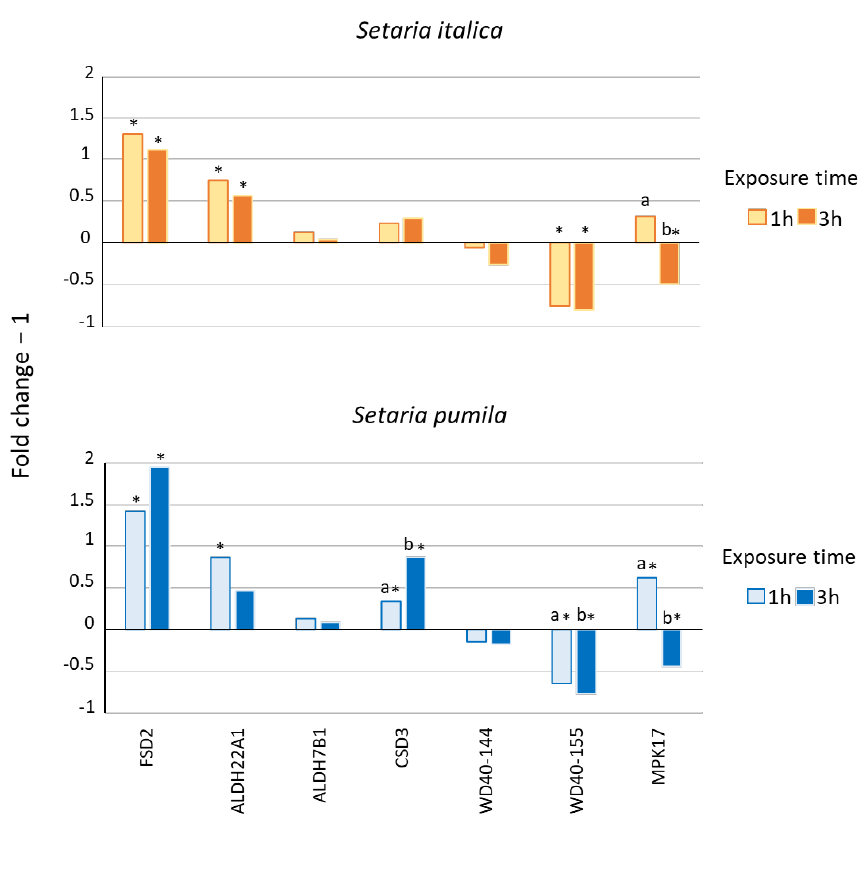
Figure 2. Target gene expression profiles in the two Setaria species after 1 and 3 h exposure to self-DNA. Data refer to fold change − 1 for each target gene after exposure to ultra-purified self-DNA solutions, for 1 and 3 h, at the concentration of 90 ng/µL. Different letters above bars indicate statistically significant differences in ∆ Cq means between exposure times within each gene ( t test for independent samples with Bonferroni’s correction for multiple comparisons). Asterisks indicate ∆ Cq means that are significantly different from the controls ( t test for independent samples with Bonferroni’s correction for multiple comparisons. Detailed results in Supplementary Table S3).